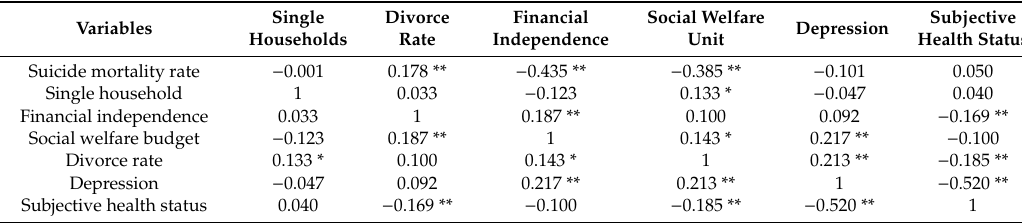
Table 3. Correlation between suicide rate and independent